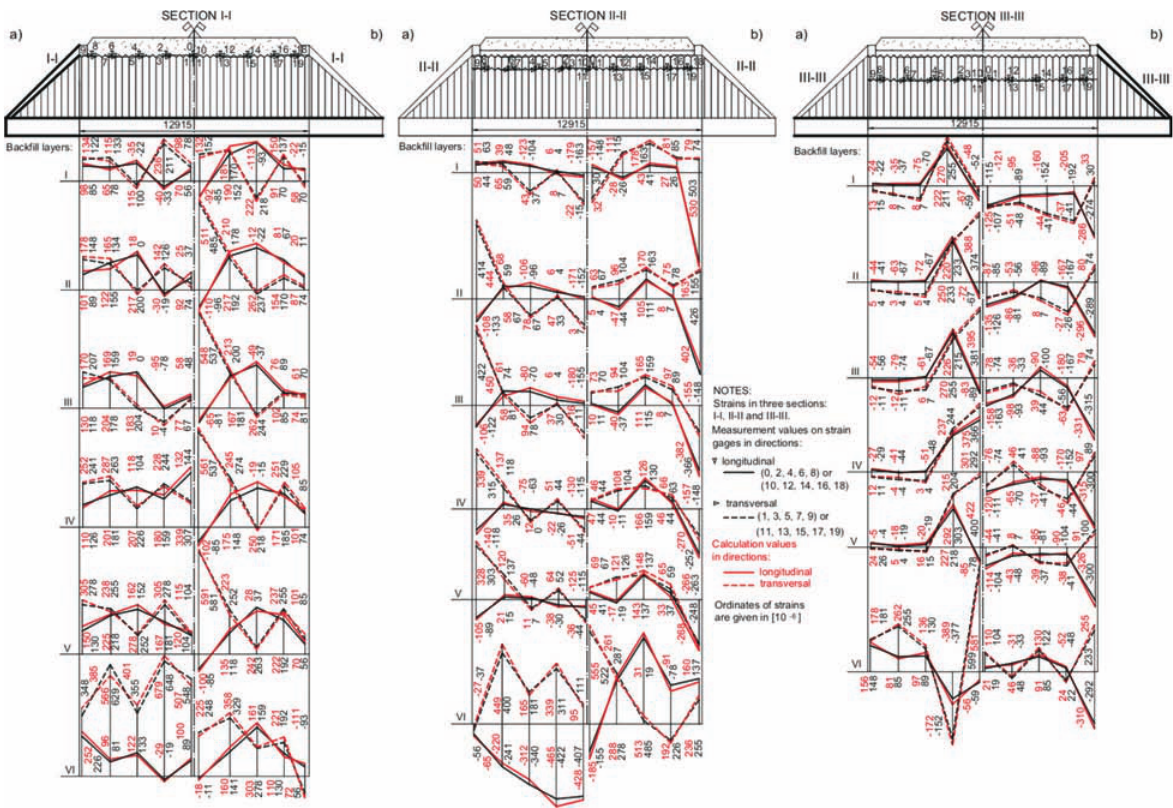
fig. 9. Graphs of max strains measured and calculated in selected points of steel shell structure in transversal direction of span during compaction and consolidation of each layer of soil in 3 sections I–I, II–II and III–III on: a – top of corrugations; b – bottom of